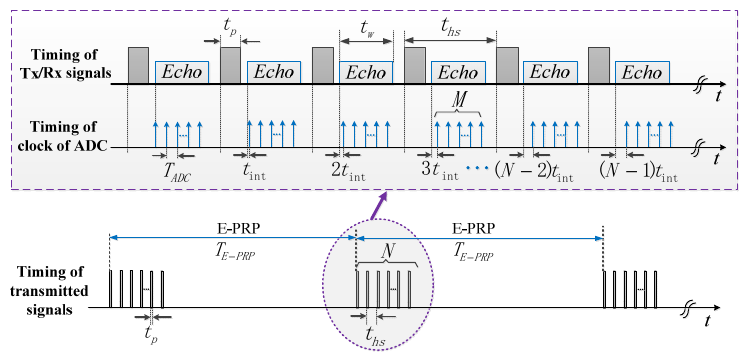
Figure 3. Timing of the non-uniform hybrid sampling technology.